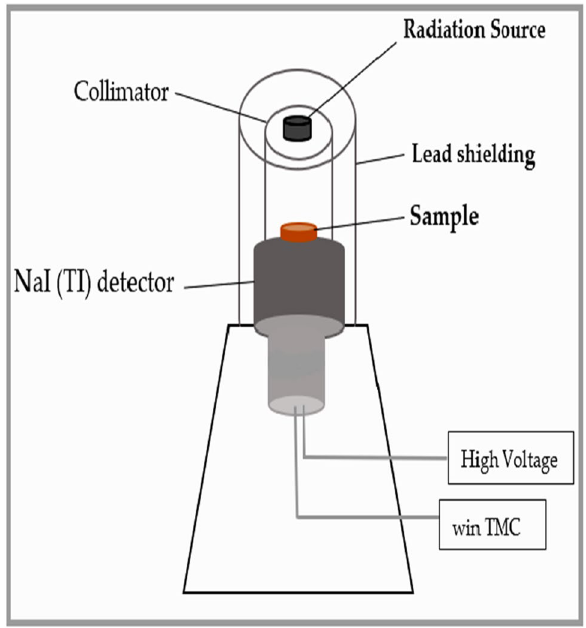
Figure 2. The arrangement of the radiating